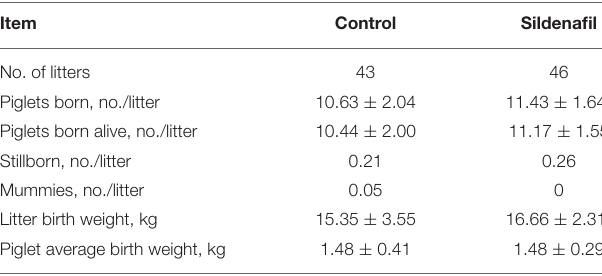
TABLE 2 | Effect of sildenafil intervention from day 0 to 30 of gestation on sow litter performance (means ±